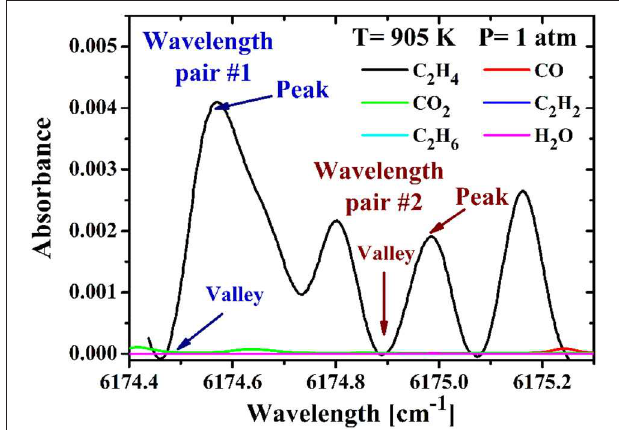
FIGURE 3 | The differential absorbance obtained of the selected wavelength pair #1 (A) and #2 (B) at 1 atm.